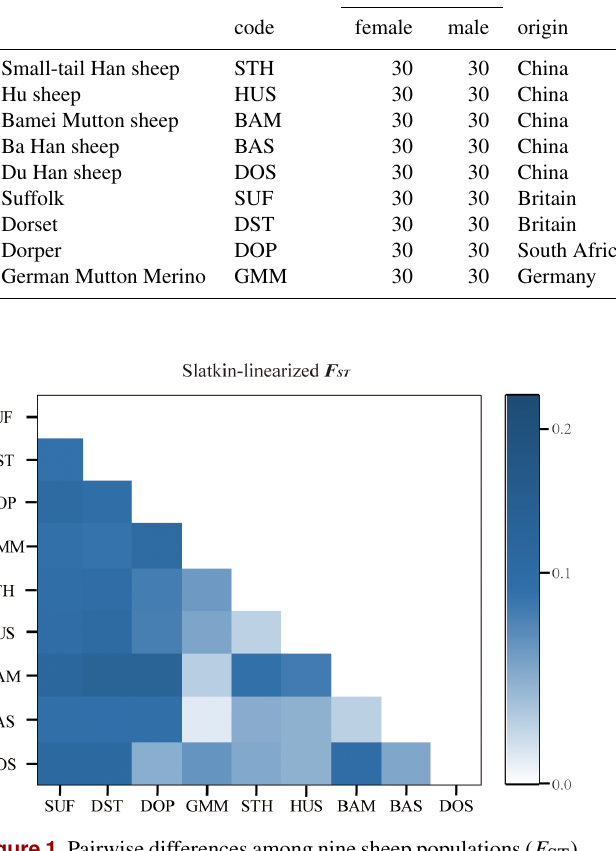
Figure 1. Pairwise differences among nine sheep populations ( F ST ) using microsatellite markers.